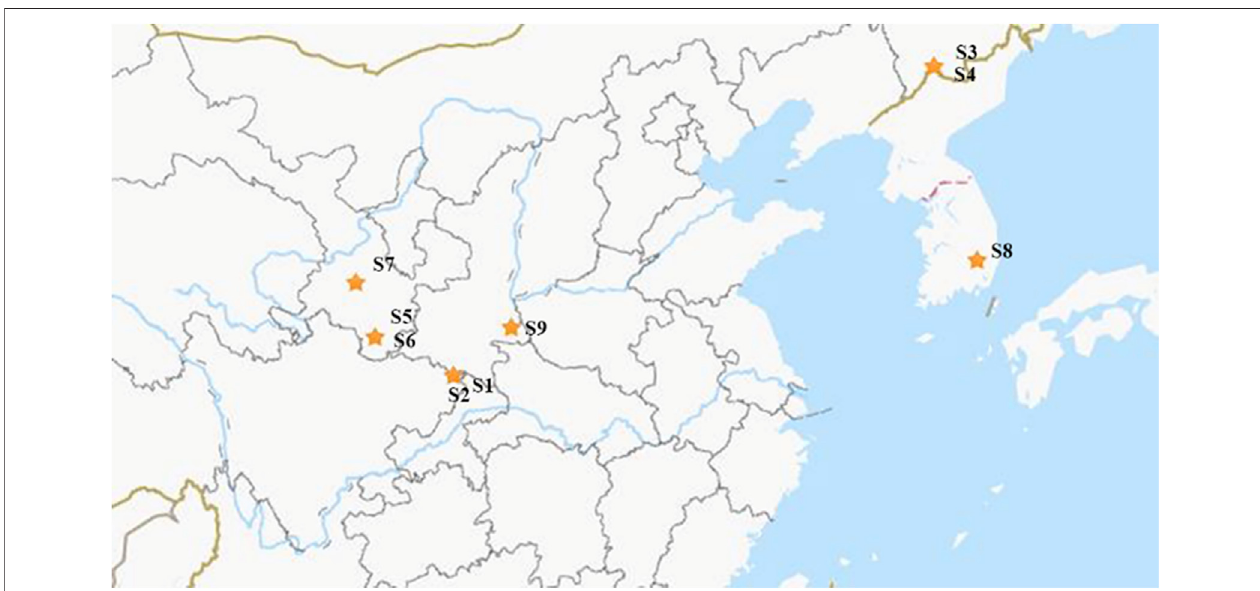
FIGURE 1 | Geographical distribution of Epimedium samples collected in this